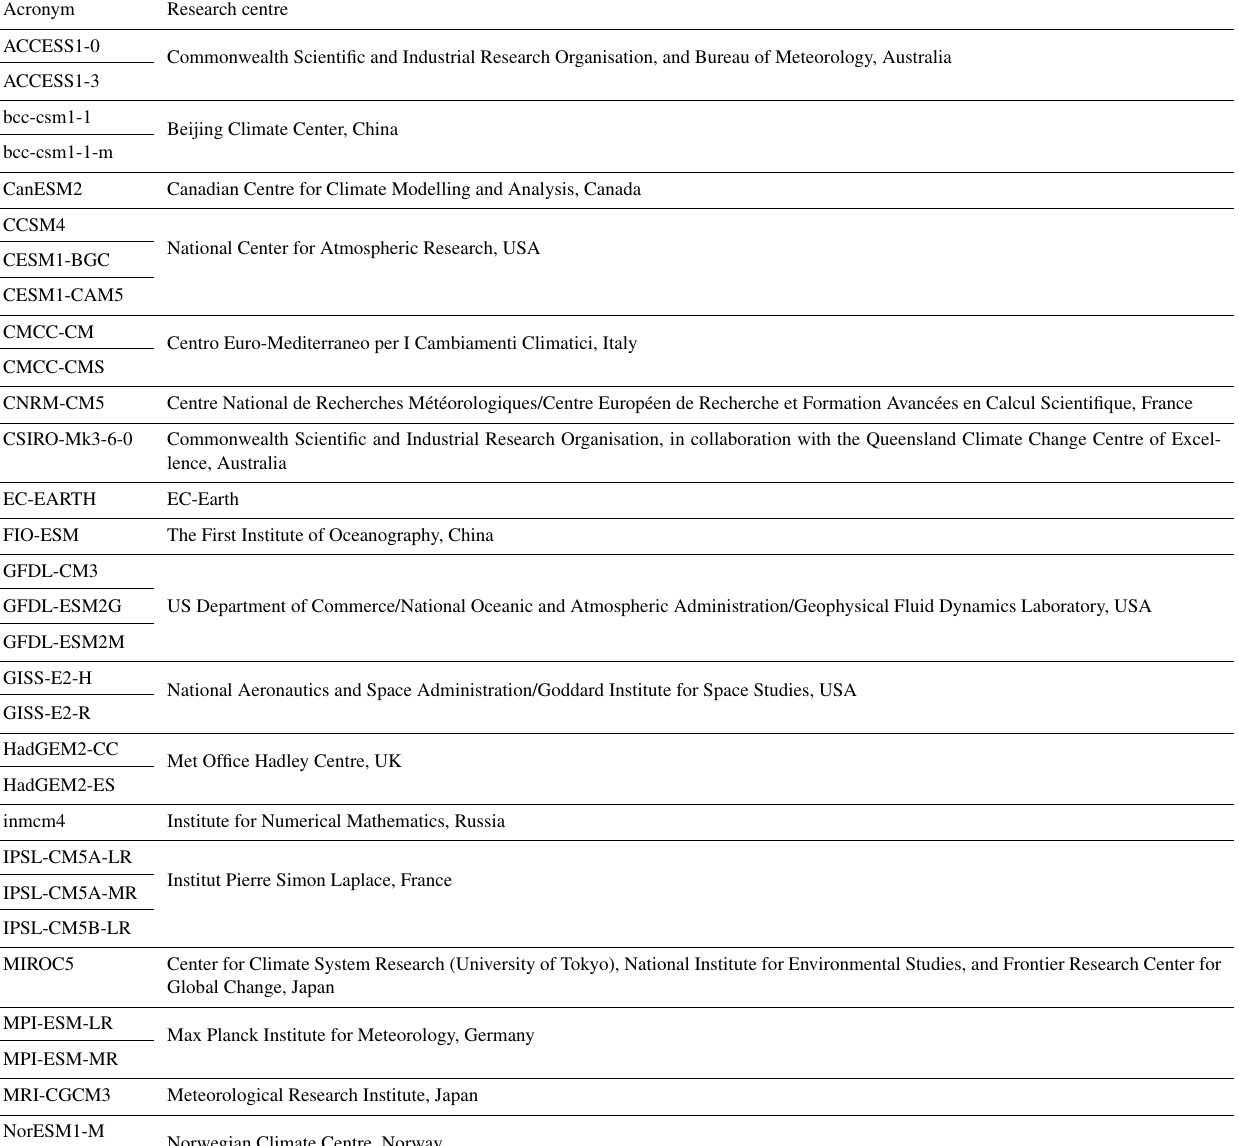
Table A2. List of models used to construct the forcing